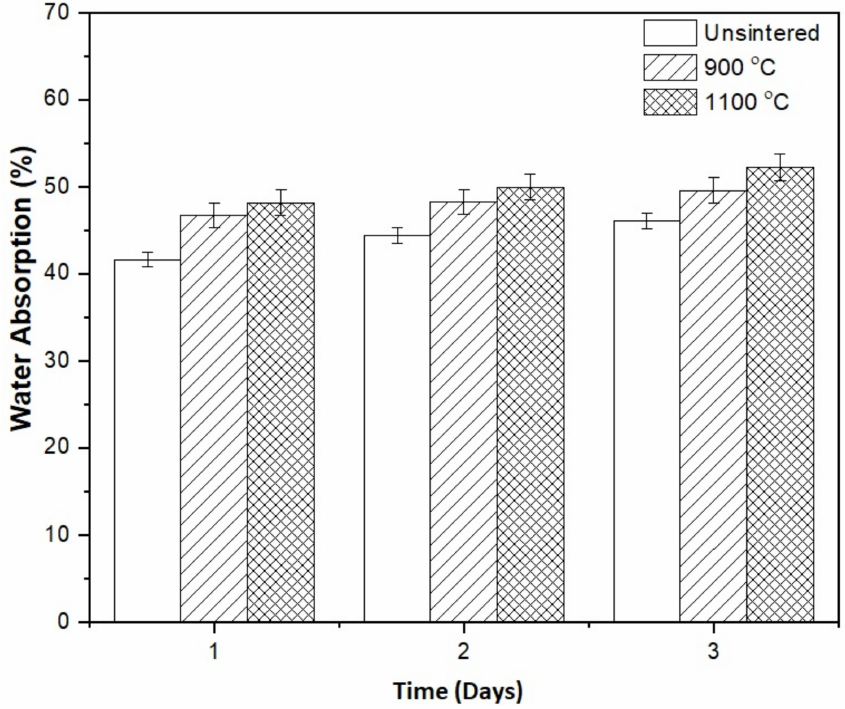
Figure 3. The water absorption of kaolin geopolymer over 3 days for unsintered and sintered samples at 900 and 1100 ◦